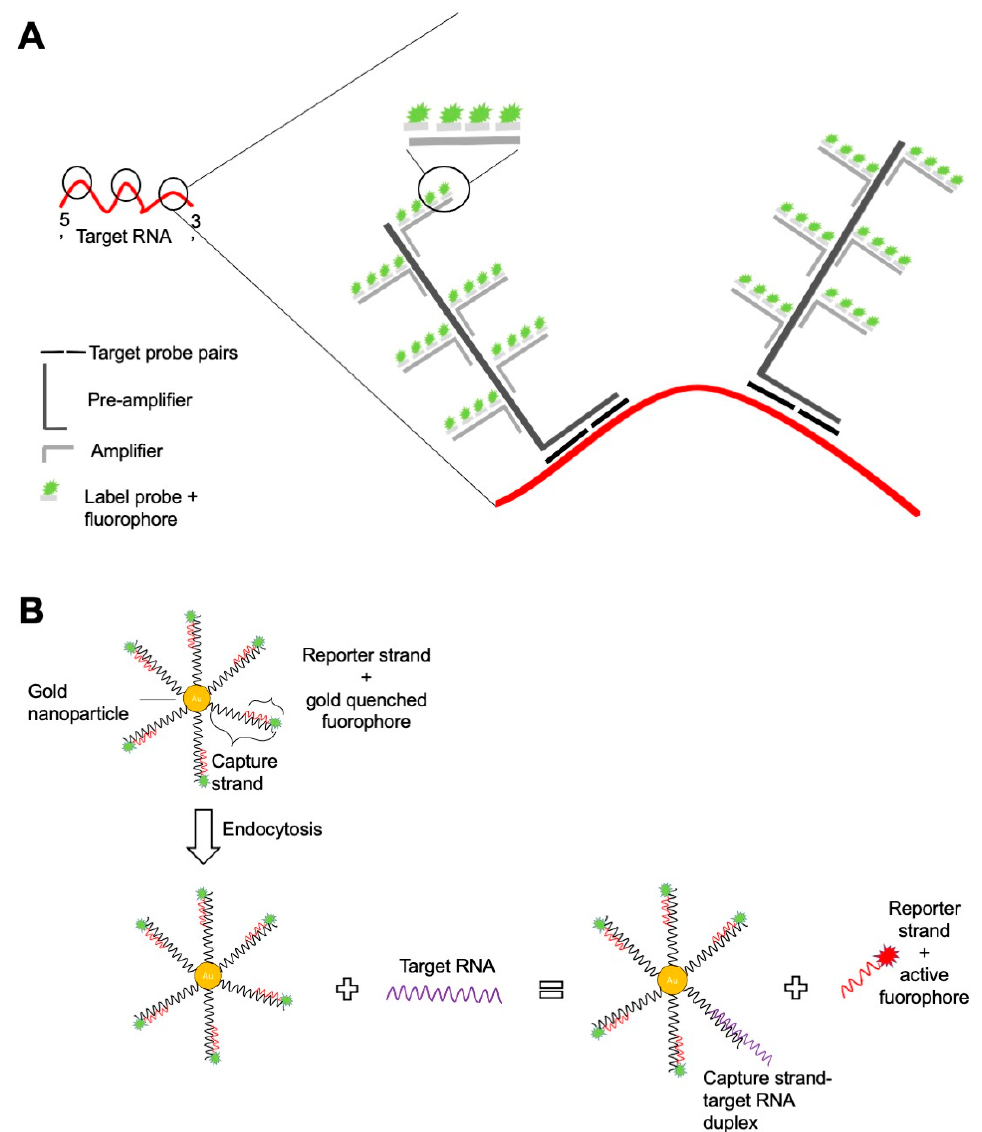
Figure 1. Scheme of the branched-DNA chemistry applied in the Prime Flow TM protocol ( A ) and of the SmartFlare chemistry ( B ). Table 1. RNA and protein analysis by flow cytometry.